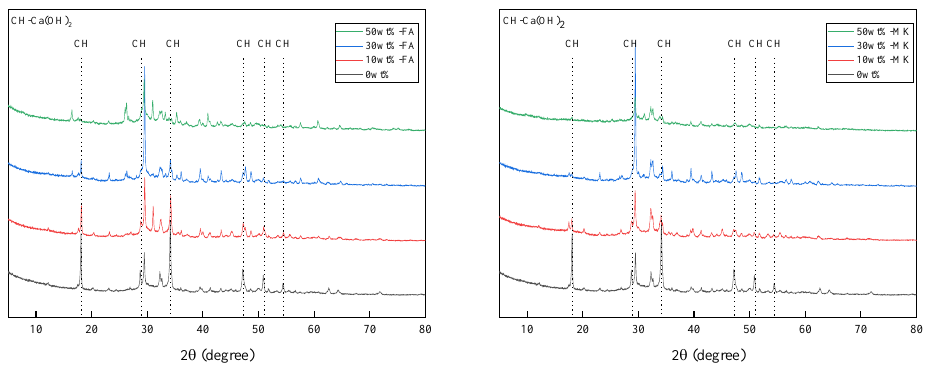
Figure 6. XRD patterns of cement pastes containing 0%, 10%, 30%, and 50% fly ash and metakaolin that were cured at 20 °C for 28 days.